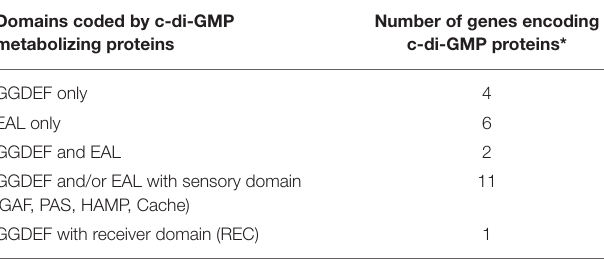
TABLE 2 | Putative c-di-GMP-related proteins in B. cenocepacia K56-2. Domains coded by c-di-GMP metabolizing